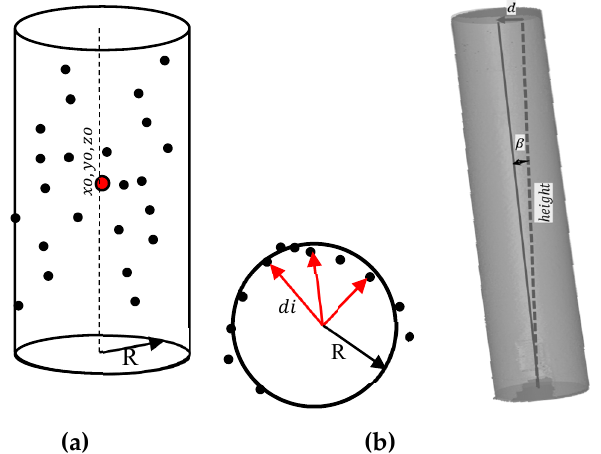
Figure 2. Fitting points to a cylinder primitive and the out of plumb illustration. ( a ) Fitting of a cylinder defined by seven parameters. ( b ) Out of plumb illustration.